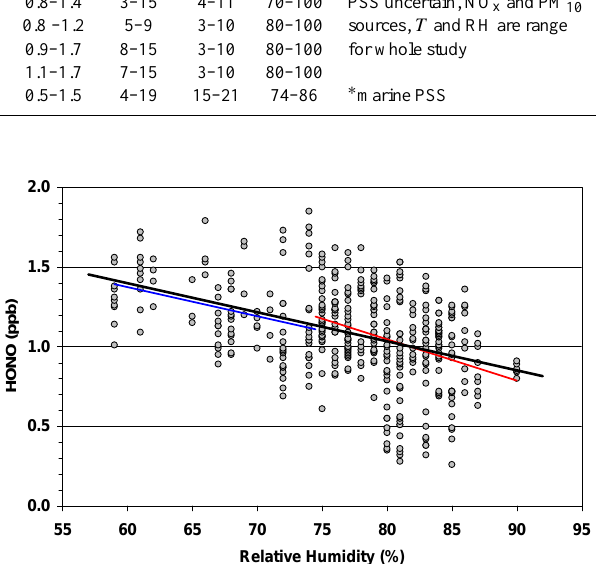
Fig. 7. Relative humidity dependence of HONO measured at Saturna Island during the PSS time period: 22:00–05:00. Black line – linear fit using all data ( C HONO = 2 . 47( ± 0.35)ppb − 0.0182( ± 0.0049)*RH%; R 2 = 0 . 17). Blue and red lines show lin- ear fit for RH < 75% and RH ≥ 75%, respectively. All negative de- pendencies are statistically significant at the 95% confidence